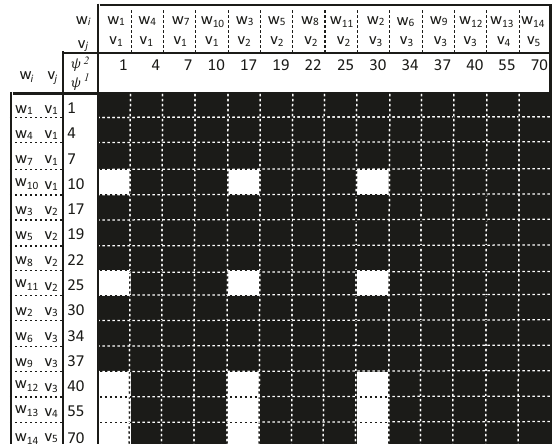
Figure 7: Adjacency matrix 𝐴 𝜌 (𝜙,𝜓) composed of sequence events (dark filled), for the acute orthopedic